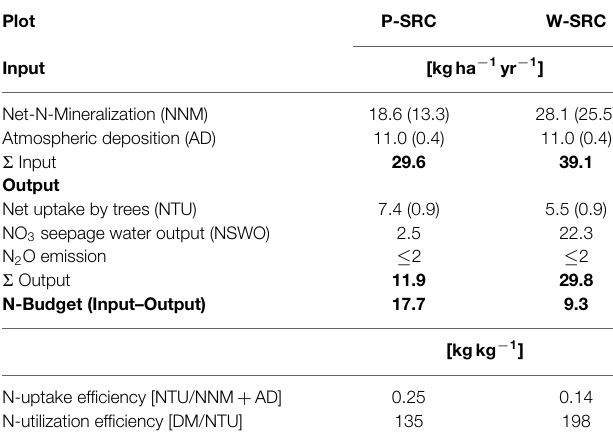
TABLE 2 | Mean ( (cid:6) SD) initial N-budget and N-use efficiency estimates for SRC in Reiffenhausen comprising poplar (P-SRC) and willow (W-SRC) plantations